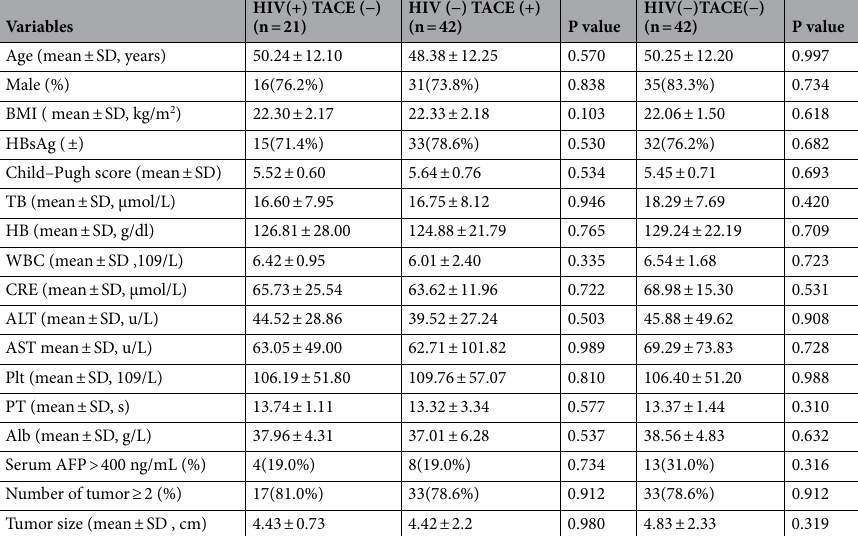
Table 3. Baseline characteristics. BMI body mass index, HBsAg hepatitis B surface antigen, TB total bilirubin, AFP Alpha-fetoprotein, PT prothrombin time, WBC white blood cell, Cre creatinine, HB hemoglobin, Plt platelet, Alb albumin.